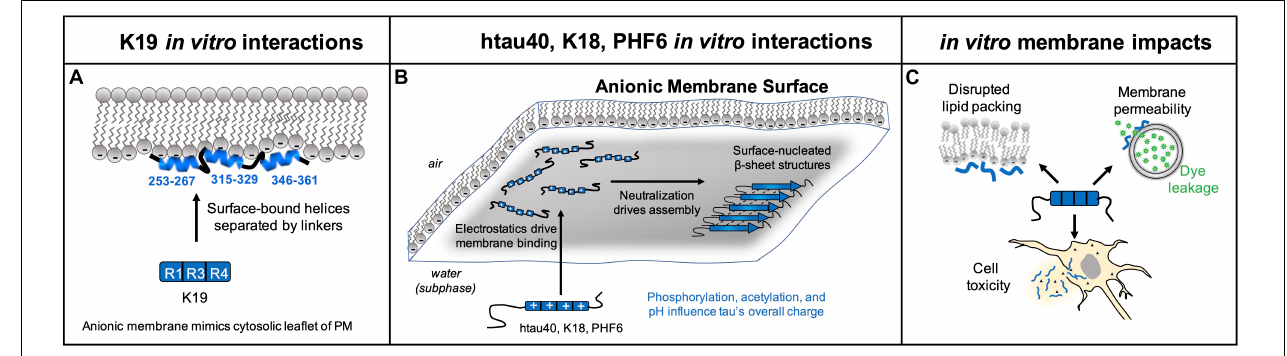
FIGURE 3 | In vitro experiments have documented that membranes promote tau folding. (A) K19 forms a partially helical structure when interacting with a pure anionic membrane, where experiments with model anionic membranes were designed to mimic the cytoplasmic leaflet of the plasma membrane. (B) htau40, K18, and PHF6 assemble into β -sheet rich structures when binding a membrane containing > 25% anionic lipids. Tau’s membrane affinity is driven by favorable electrostatic interactions with anionic lipid headgroups, and assembly on the membrane is promoted by charge neutralization. (C) In vitro experiments show tau can have deleterious impacts on membrane structure of synthetic vesicles including disrupted lipid packing, membrane permeability to small molecule reporters, and cell toxicity resulting from interactions with tau fibrils and aggregation intermediates. Note that in vivo tau is on the inside of vesicles involved in transfer of tau in or out of